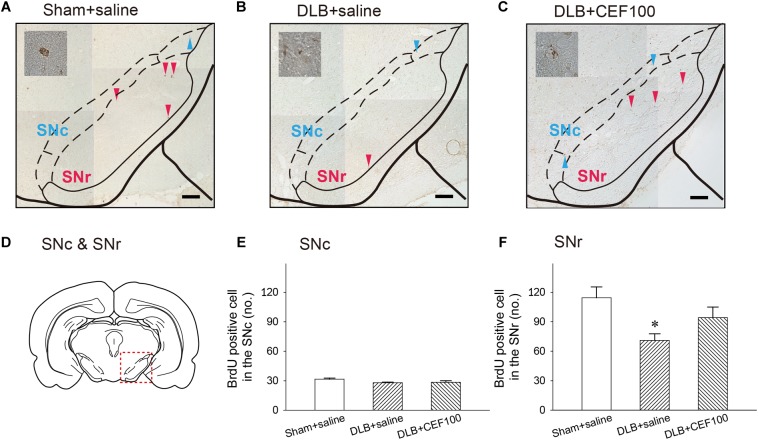
Effect of ceftriaxone (CEF) on neurogenesis in the substantia nigra (SN). The treatment and group name are the same as those in Figure 1. (A–C) Coronal sections in the SN. Newborn cells are indicated by BrdU labeling in representative coronal sections. Magnification, 200×; bar, 50 μm. High magnification images (1000×) of BrdU-positive cells are shown in the insets. (D) SN. Quantitative results of pars compacta (SNc) (E) and of pars reticulate (SNr) (F) are shown. ∗P < 0.05, compared with Sham+saline group. The data are expressed as the mean ± SEM.